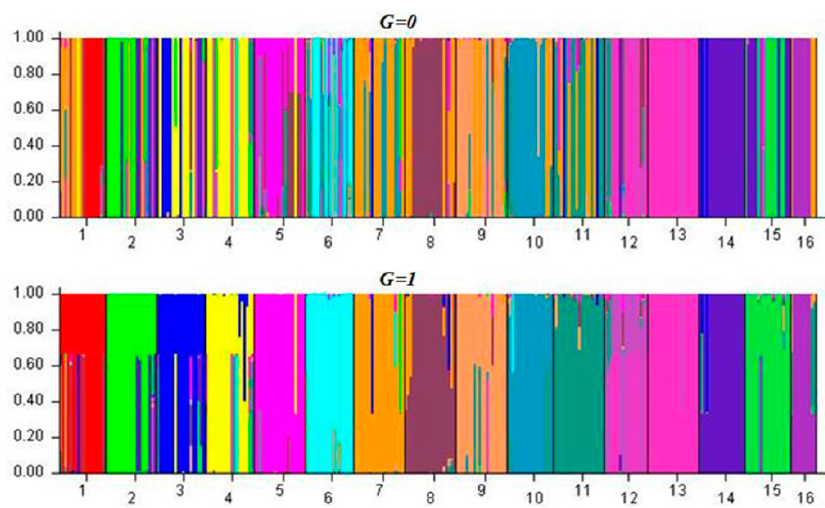
Figure 6. Admixture (G: Generation back; G = 0 and 1, single parent and itself) at K = 16 for each population of C. dactylon in the last two generations.